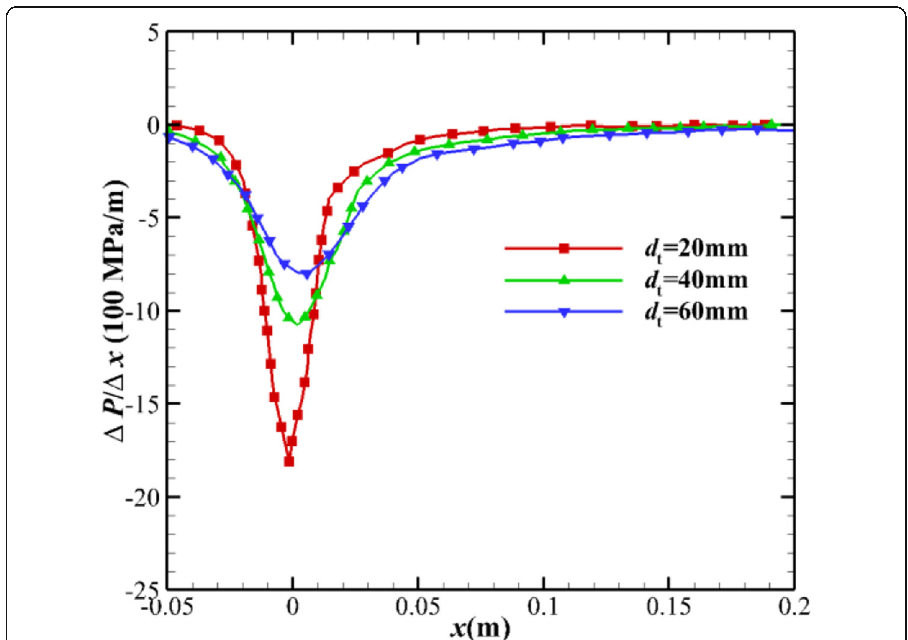
Fig. 9 Comparison of centerline pressure gradient distribution based on the different throat